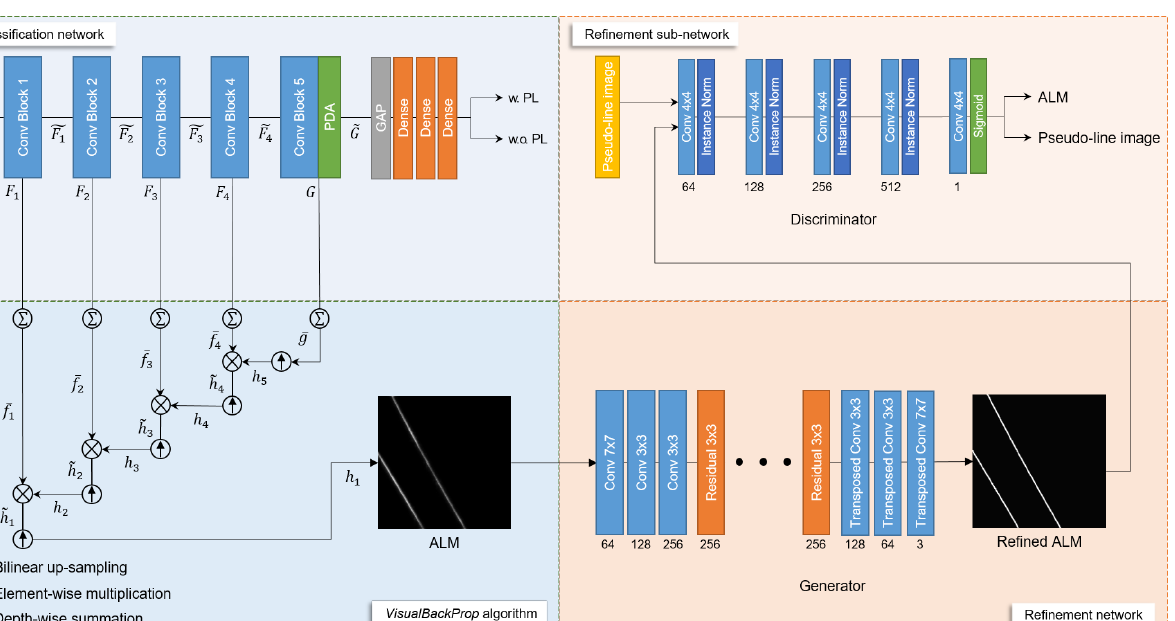
Figure 1. Overview of the proposed method. The ( left ) part shows the base network for extracting power line (PL) features and obtaining localization mask. The ( right ) part presents the refinement network and a sub-network for the adversarial learning of the refinement